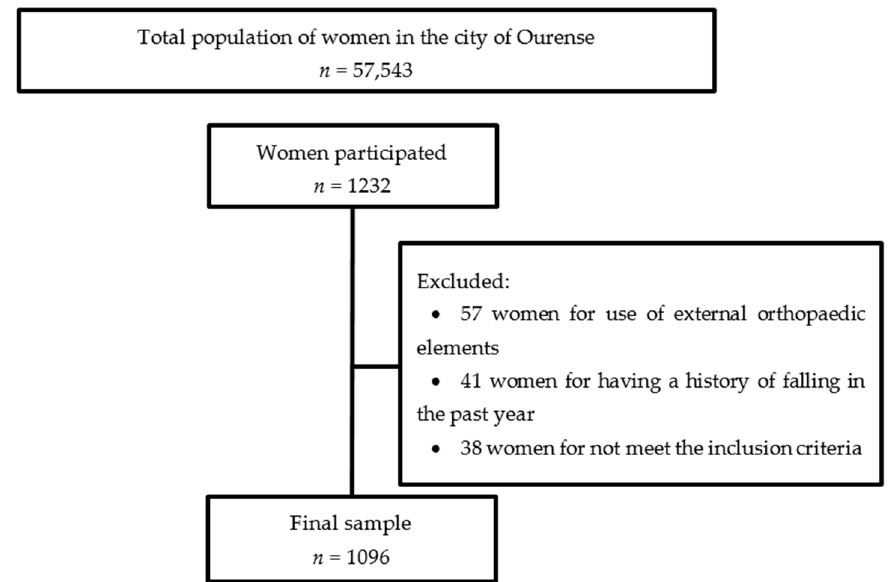
Figure 1. CONSORT flow